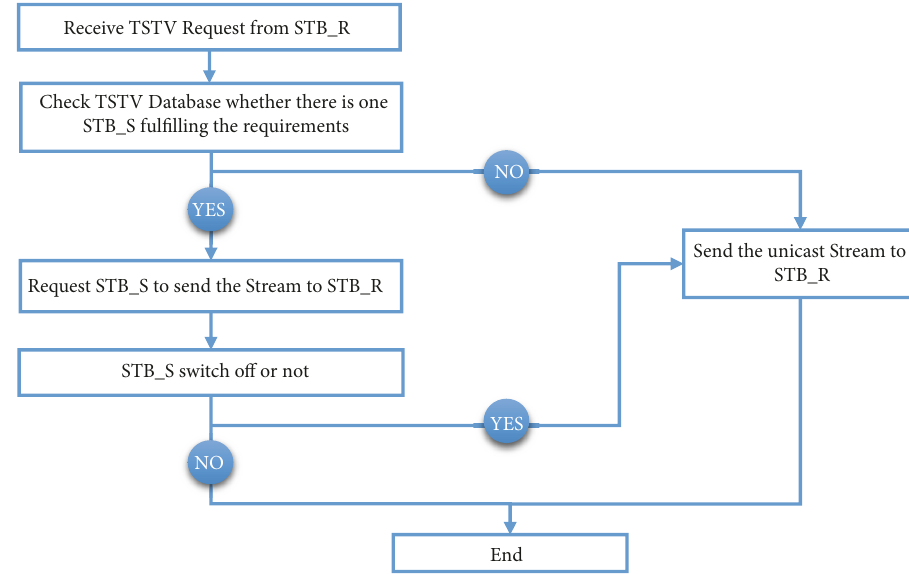
Figure 9: The proposed TSTV solution main